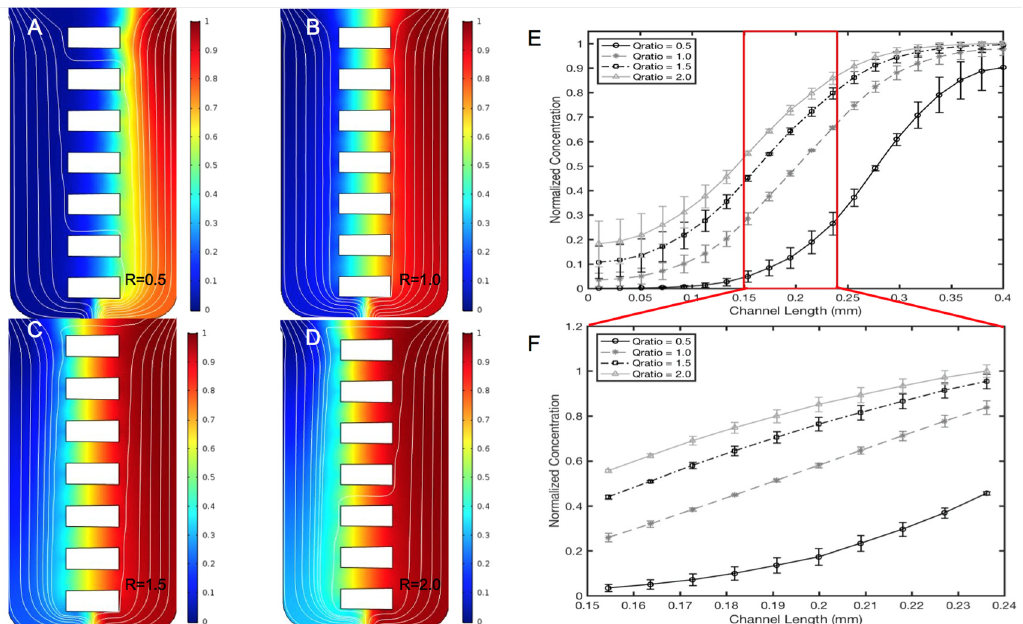
Figure 5. Concentration profiles of targeted fibroblast growth factor (FGF) ligand are generated within the μ OS using different volume flow rate ratios of the left and right inlet ports, R = Q R /Q L . ( A ) The concentration profile within the μ OS system when R = 0.5 is used, which is generated when the volume flow rate through the left, or sink port, Q L, is twice the volume flow rate through the right, or source port, Q R . ( B ) The concentration profile within the μ OS system when the volume flow rate ratio, R, is equal to 1.0. ( C ) The concentration profile within the μ OS system when R is equal to 1.5 and ( D ) when R is equal to 2.0. ( E ) Concentration profile along horizontal positions of the μ OS device for varying volume flow rate ratios, 0.5 ≤ R ≤ 3.0. The region between the vertical lines denotes the microarray. ( F ) The inset demonstrates the concentration profiles along the microarray for varying volume flow rate ratios, 0.5 ≤ R ≤ 3.0.